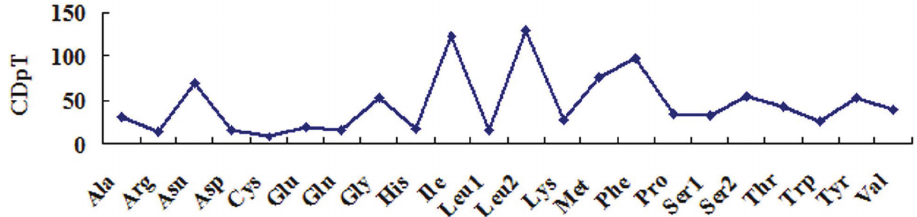
Figure 2. The amino acids usage in the mitogenome of T. japonica . CDpT = codons per thousand codons.